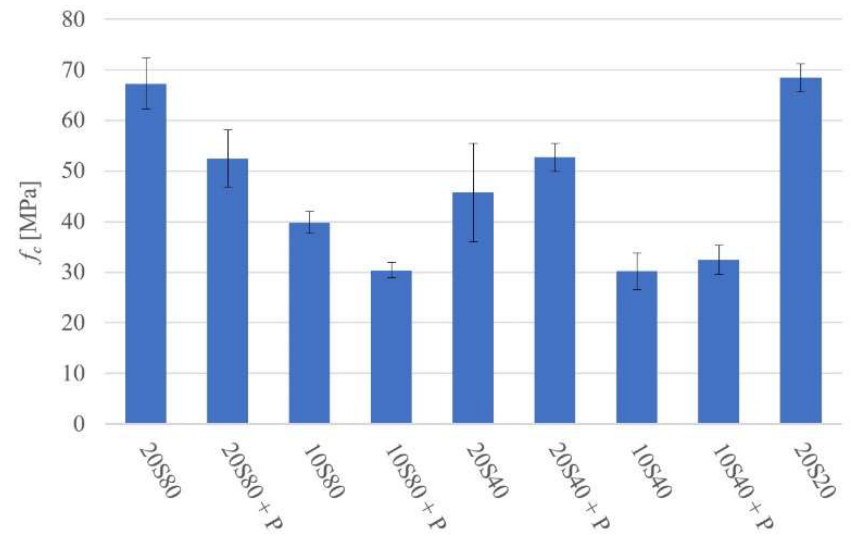
Figure 4. Compressive strength at 28 days. The 28-day flexural strength ( f f ) values varied between 3.5 MPa for mortar 20S80P and 6.1 MPa for mortar 20S20, as shown in Figure 5.